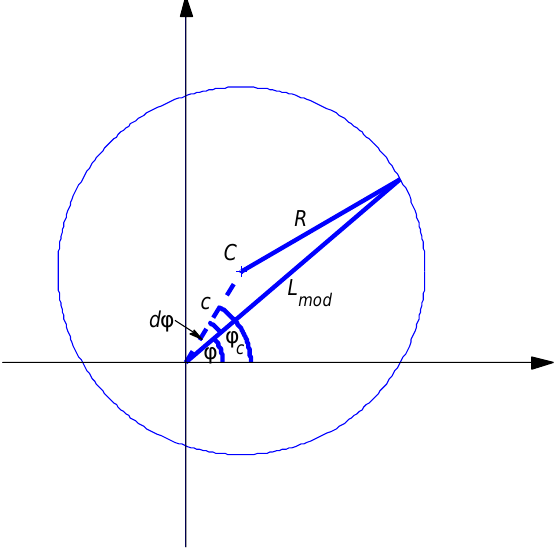
Figure 8. Sketch of the applied model for a fixed level of geomag- netic